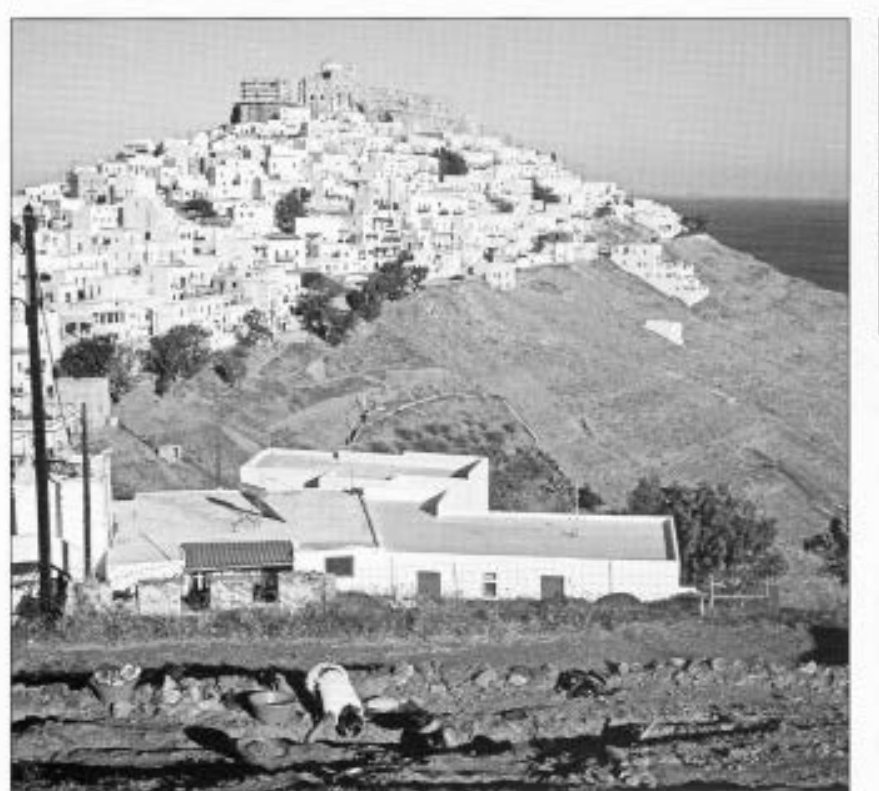
Figure 2 The citadel ofChora seen from the neighbouring hill ofKatsalos, where work is in progress on some of the burials. The Southwest Kylindra site is located just below the houses of the